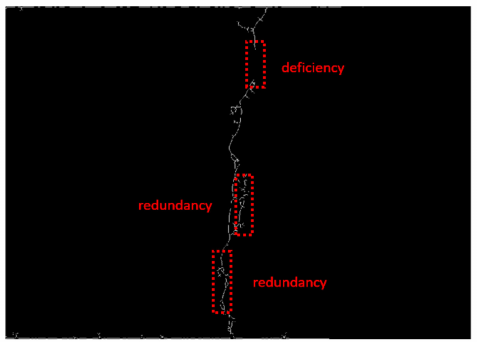
Figure 8. Central skeleton method.